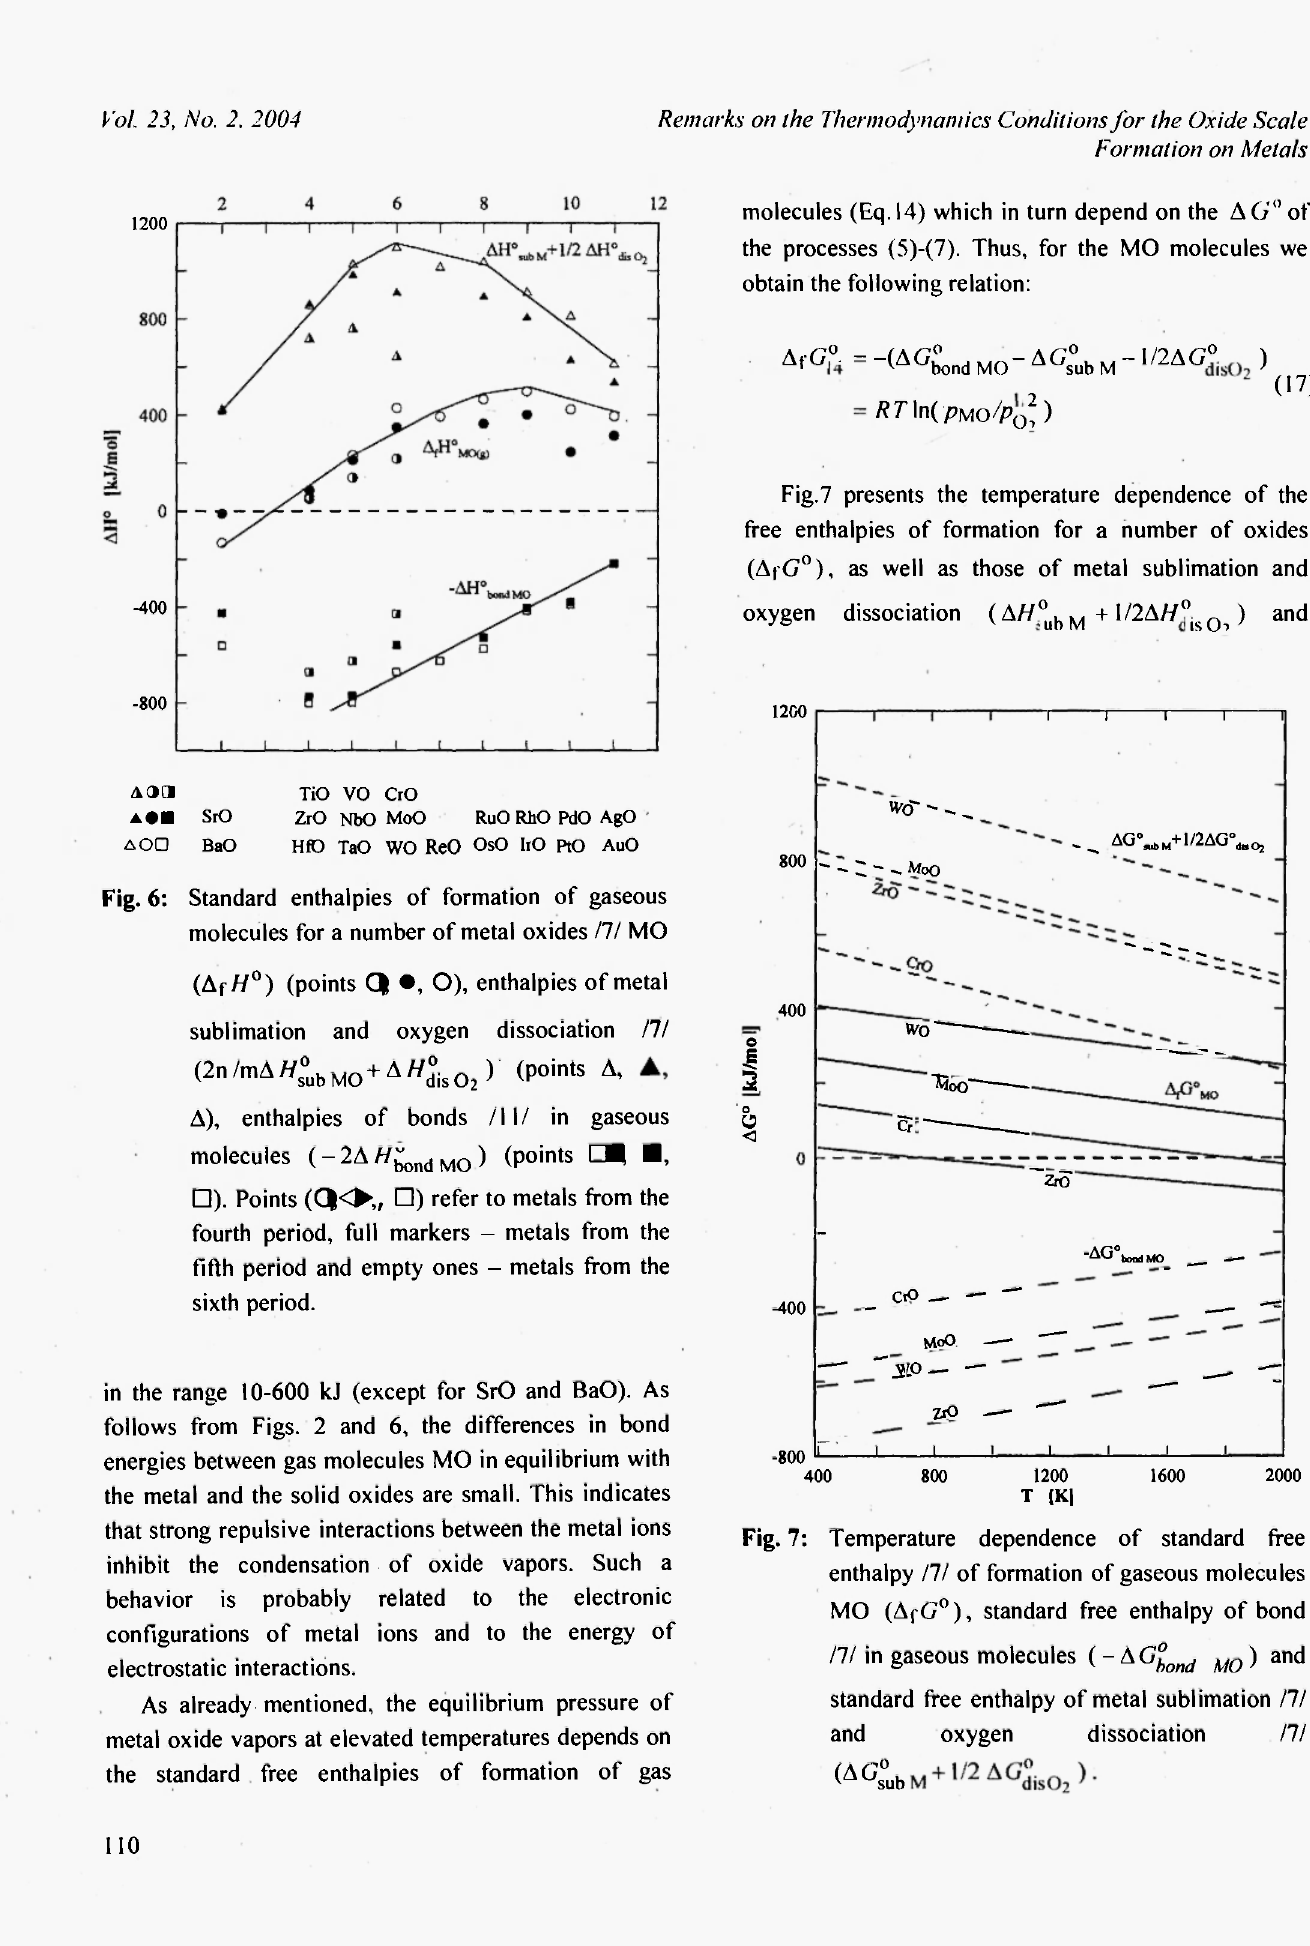
Fig. 6: Standard enthalpies of formation of gaseous molecules for a number of metal oxides 111 MO (AfH°) (points Q ·, O), enthalpies of metal sublimation and oxygen dissociation ΠI (2n/mA// s 0 ubMO + AW d ° isO2 ) (points Δ, Δ), enthalpies of bonds /ll/ in gaseous molecules (- 2A MO ) (points ΠΛ, •, • ). Points ( Q < >„ •) refer to metals from the fourth period, full markers - metals from the fifth period and empty ones - metals from the sixth period.